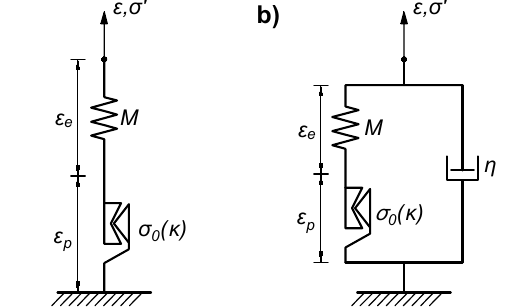
Figure 6. Rheological schemes proposed for drained conditions: ( a ) Spring and Kepes element connected in series, ( b ) Spring and Kepes element connected in parallel with